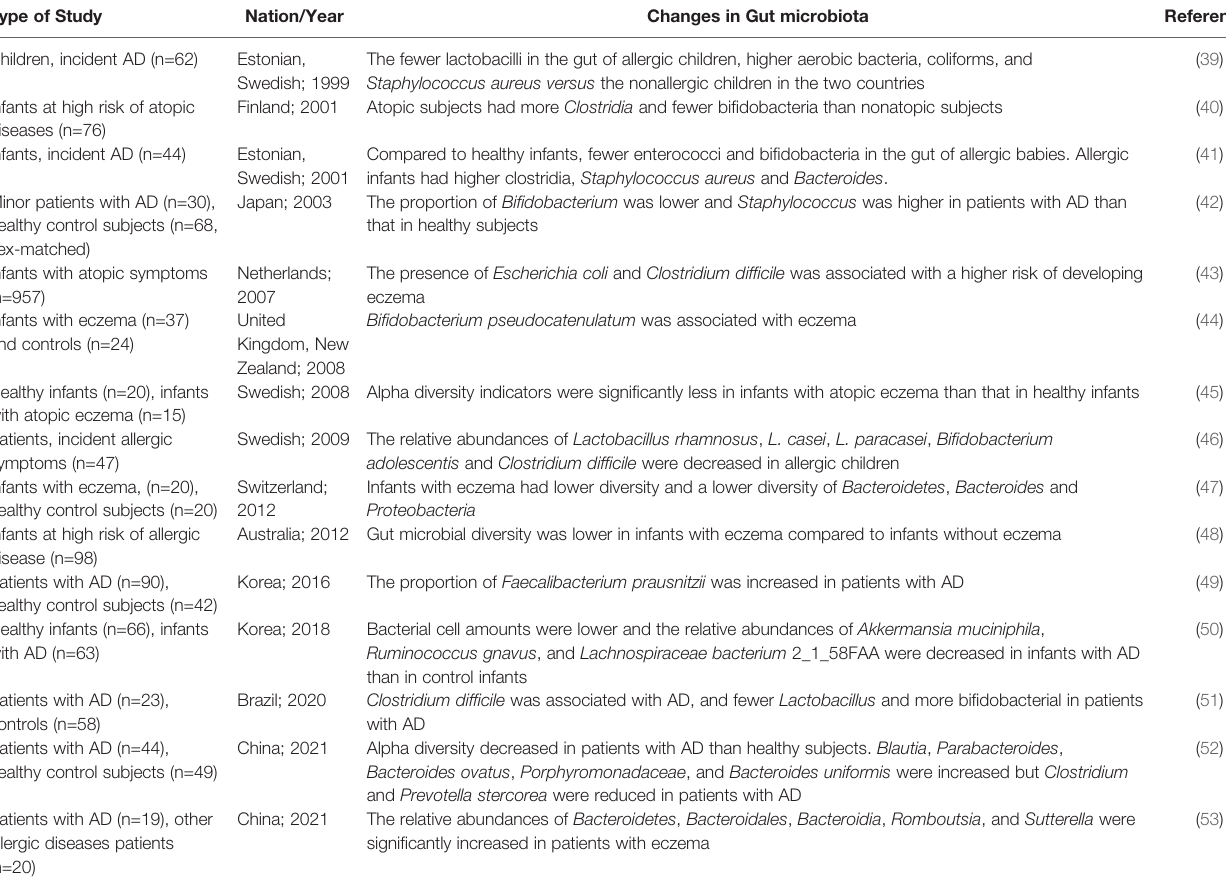
TABLE 1 | Changes in the gut microbiota of patients with atopic